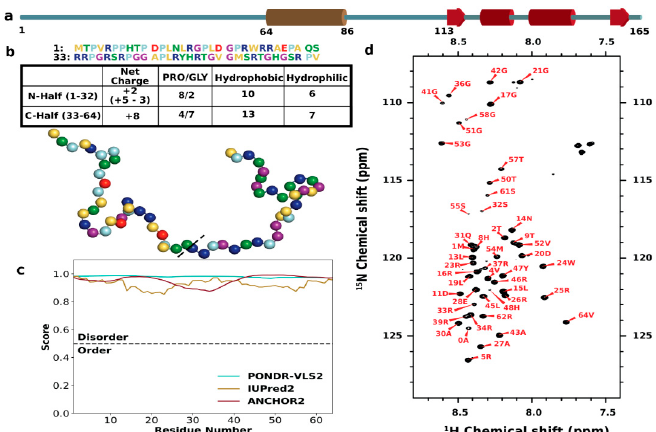
Figure 1. Amino acid sequence and disorder of ChiZ. ( a ) Domain organization of full-length ChiZ, composed of a disordered N-terminal region (residues 1–64), a transmembrane helix (residue 65–86), a disordered linker (residues 87–112), and a LysM domain (residues 113–165). ( b ) Sequence and amino acid composition of ChiZ1-64. In both the sequence and an illustrative conformation, residues are colored in the following scheme: cationic, blue; anionic, red; prolines, light blue; glycines, purple; hydrophilic, green; and hydrophobic, yellow. ( c ) Disorder predictions from three web servers, PONDR-VLS2, IUPred2, and ANCHOR2. ( d ) 1 H- 15 N HSQC spectrum, acquired on an 800 MHz spectrometer at 25 °C in 20 mM of phosphate buffer (pH 7.0) with 25 mM of NaCl.